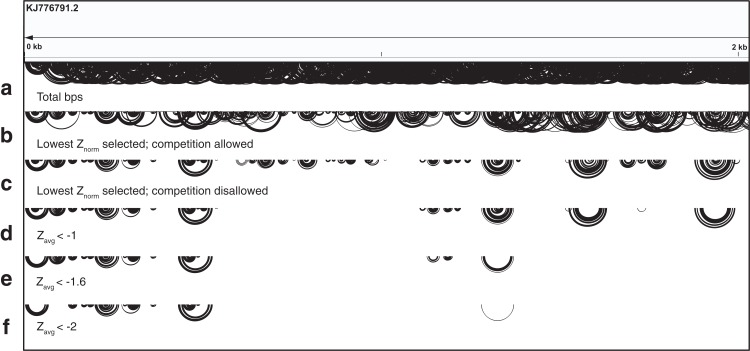
Depiction of the ScanFold-Fold processing of scanning window results.This image depicts the base pairs identified on the first 2,000 nts of the ZIKV genome (accession KJ776791.2) through each step of ScanFold-Fold processing, as base pairing tracks (Busan & Weeks, 2017) on IGV (Thorvaldsdottir, Robinson & Mesirov, 2013). (A) The first track shows the totality of base pairs predicted throughout the ScanFold-Scan process. (B) The second track depicts the base pairs which remain after ScanFold-Fold selects the most favorable base pair (according to the lowest Znorm; see Methods Eq. (3)) per i nucleotide of the sequence; competition is allowed, that is, multiple partners are permitted to pair with the same nucleotides. (C) The third track shows the base pairs which remain after prohibiting multiple pairing partners per nucleotide; that is, competition is disallowed whereby only a single pairing partner is allowed per i or j nucleotide. This track is equivalent to the “no filter” results from ScanFold-Fold. The base pairs from this track are then subjected to filtering based on their Zavg (see Methods Eq. (2)). The final tracks depict which base pairs from the results above possessed Zavg scores less than (D) −1 (E) −1.6 (one standard deviation below the mean z-score) and (F) −2.